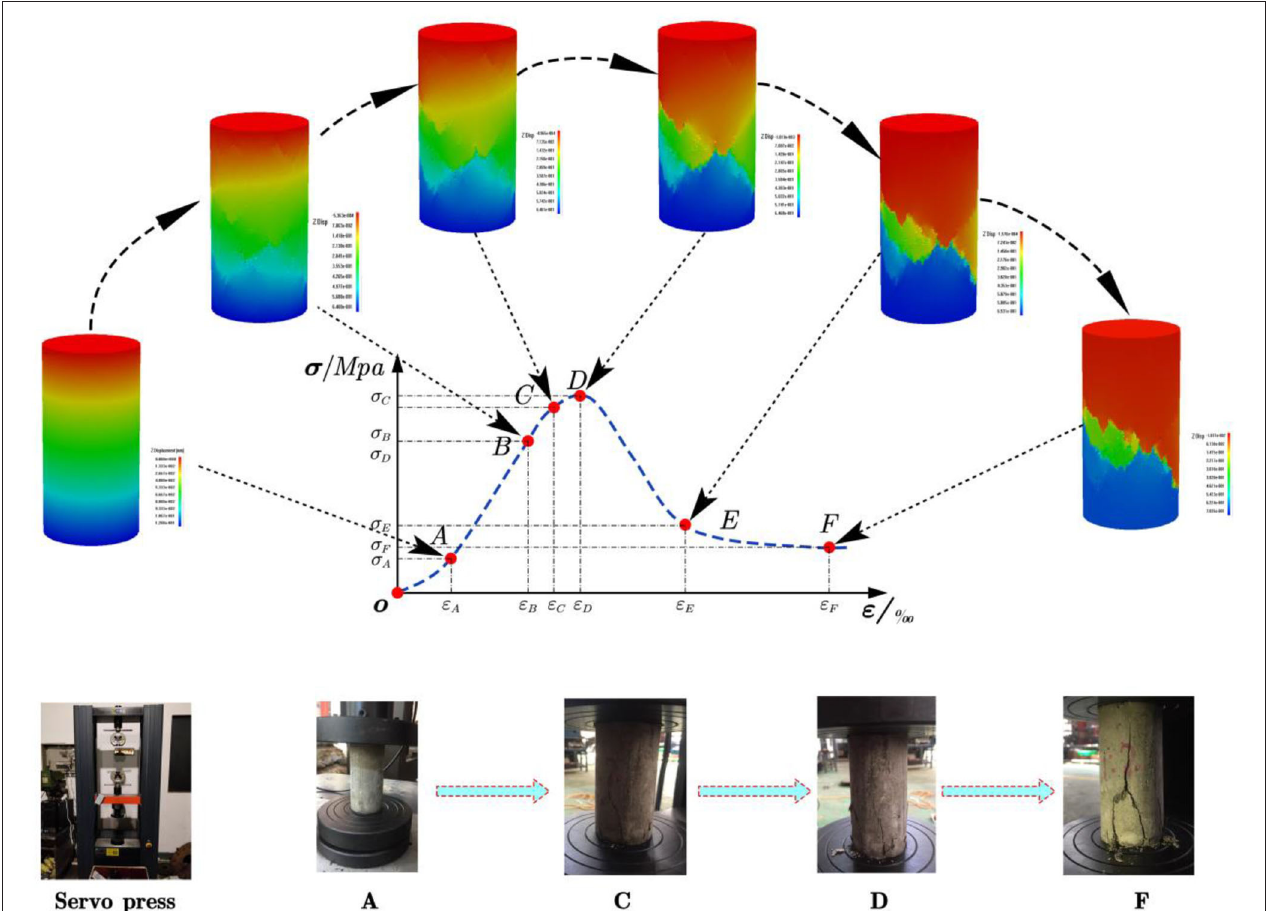
FIGURE 1 | Full stress–strain curve of